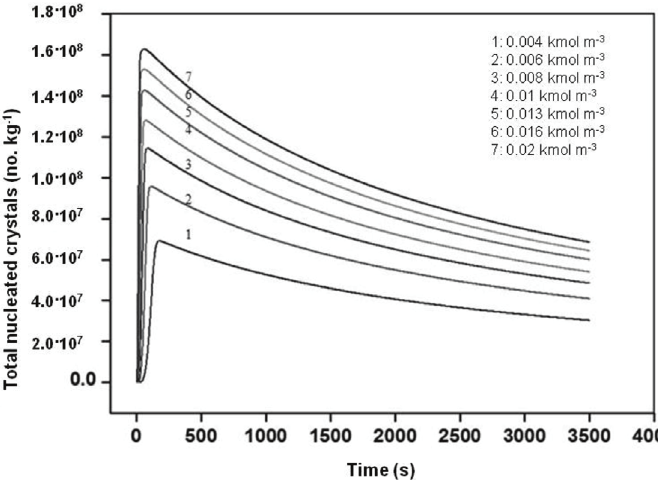
Fig. 5 – Effect of concentration of reactants on total crystals nucleated at 5 mL min –1 feed rate